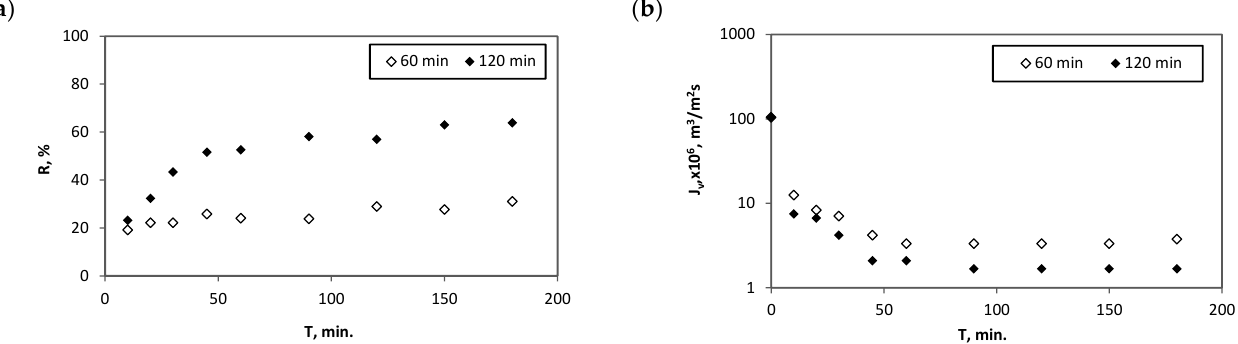
Figure 9. Changes in retention coefficient ( a ) and permeate flux ( b ) during sorption-assisted MF process in the case of experiments where the effect of increasing the initial contact time of the reagents was analysed; UiO-66_MAA sorbent, C sorb. = 1 g/L.